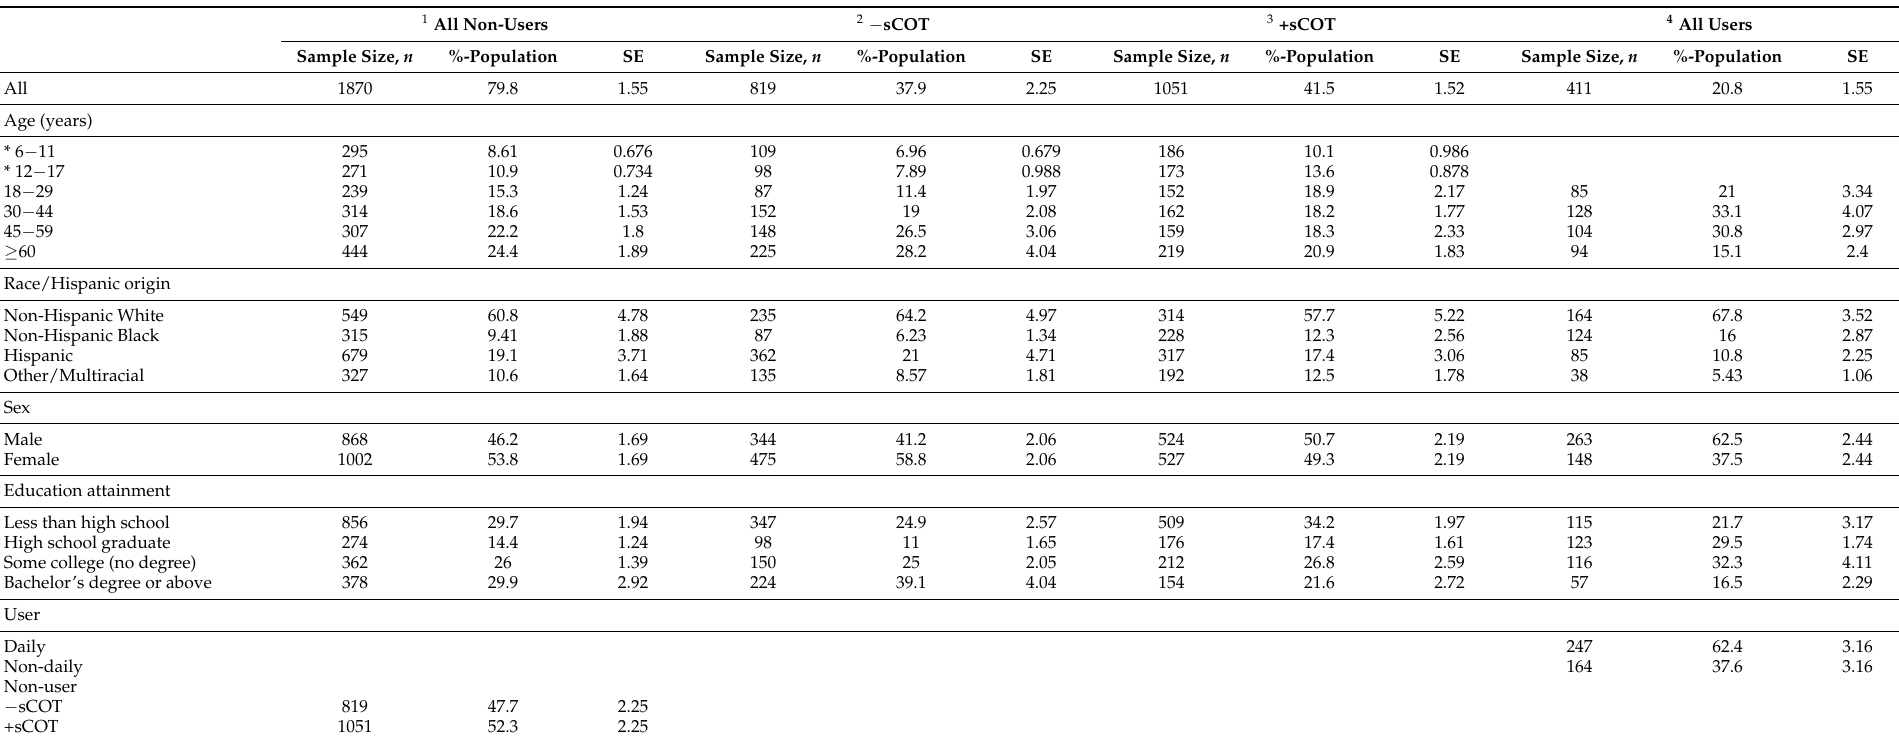
Table 1. Sample size, urinary cotinine detection rates, sample-weighted demographic distributions (%-population) and standard error (SE), in NHANES 2015–2016 ( n =